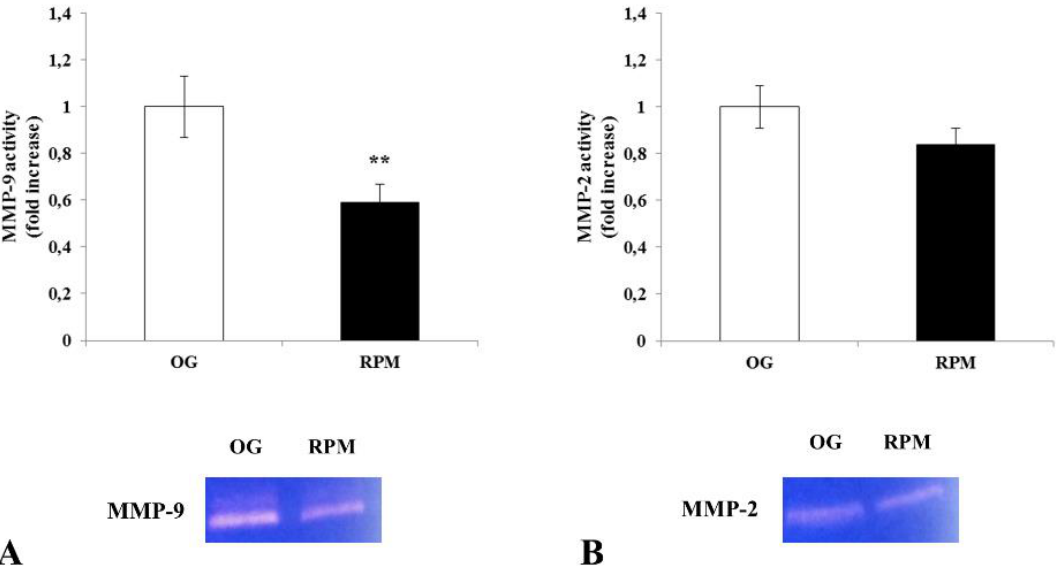
Figure 5. Effect of simulated microgravity on MMP-9 ( A ) and MMP-2 ( B ) activity in human dermal fibroblasts. Gelatin zymography shows MMP-9 and MMP-2 activity in conditioned media of human fibroblasts exposed or unexposed to the RPM for 24 h. Values are expressed as a fold increase of on-ground control (OG). Each column represents the mean value ± SD of three independent experiments, where SD is depicted as vertical bars. ** p < 0.01 RPM versus OG by unpaired two-tailed t